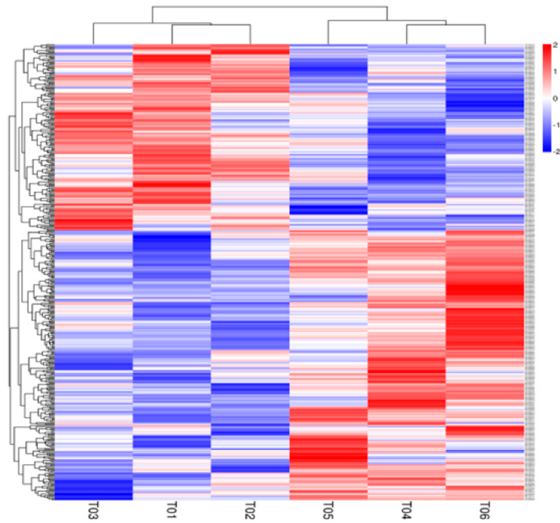
Figure 7. Characteristics of mRNA expression levels between the experimental and the control group. Hierarchical clustering map of differentially expressed genes. The abscissa represents the sample name and the clustering result of the sample, and the ordinate represents the clustering result of the differential gene and the gene. The different columns in the figure represent different samples, with different rows representing different genes. The color represents the level of expression of the gene in the sample log10. T01, T02, T03 were representative of the control group. T04, T05, T06 were representative of the experimental group, zero-mean normalization (z-score) was used to process the data.